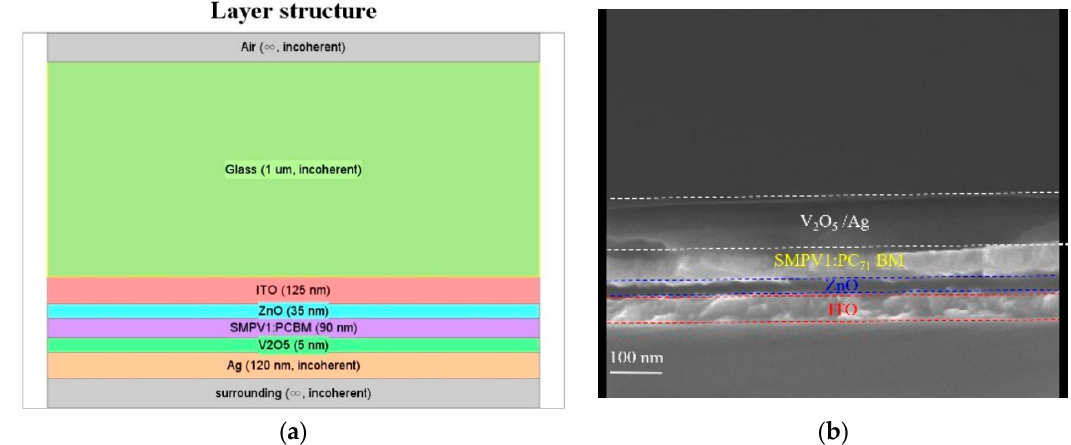
Figure 1. Schematic diagrams of the nonhalogen small molecules solar cell structures. ( b ) SEM cross-sectional image of ( a ).